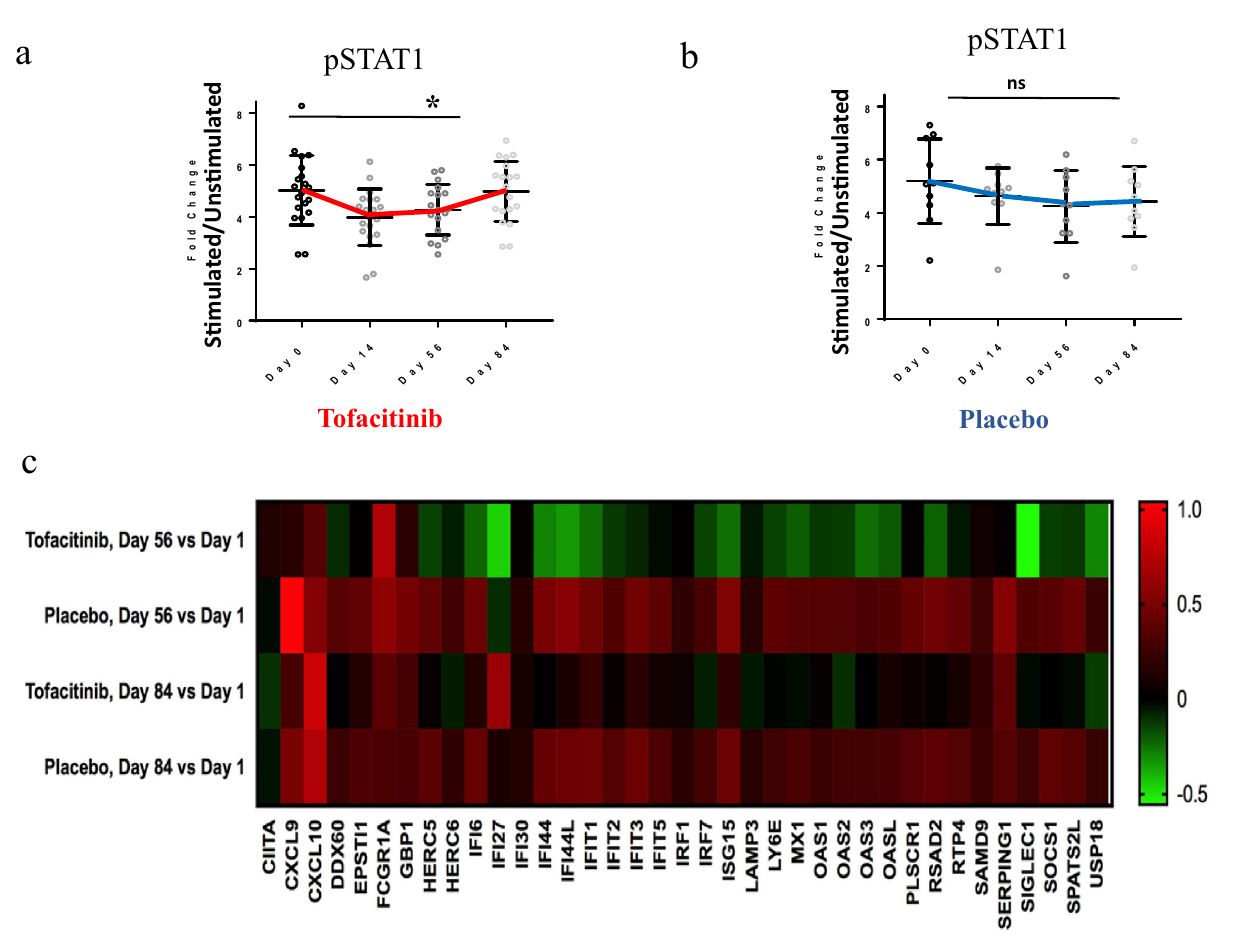
Fig. 1 Tofacitinib inhibits STAT1 phosphorylation in CD4 + T cells. a Signi fi cant inhibition of pSTAT1 in patients on tofacitinib at day 56 ( P = 0.023) with the return to baseline at day 84 n = 20 biologically independent samples. Data are presented as mean values + / − SEM. A mixed linear model for repeated measures was used. b No signi fi cant change noted in patients on placebo. n = 10 biologically independent samples. Data are presented as mean values + / − SEM. A mixed linear model for repeated measures was used. c Tofacitinib decreases the type I IFN gene signature, gene expression in peripheral blood by Nanostring: Heatmap showing interferon-stimulated gene expression in peripheral blood by nanostring: Log2 mean fold change in expression of interferon-stimulated genes from baseline to day 56 and 84 in subjects on tofacitinib ( n = 20 biologically independent samples) and placebo ( n = 10 biologically independent samples). Source data are provided as a Source Data fi le. Results shown as fold change in stimulated vs. unstimulated cell population. A mixed linear model for repeated measures was used. Unpaired two-tailed, t test were used where appropriate. No adjustments were made for multiple